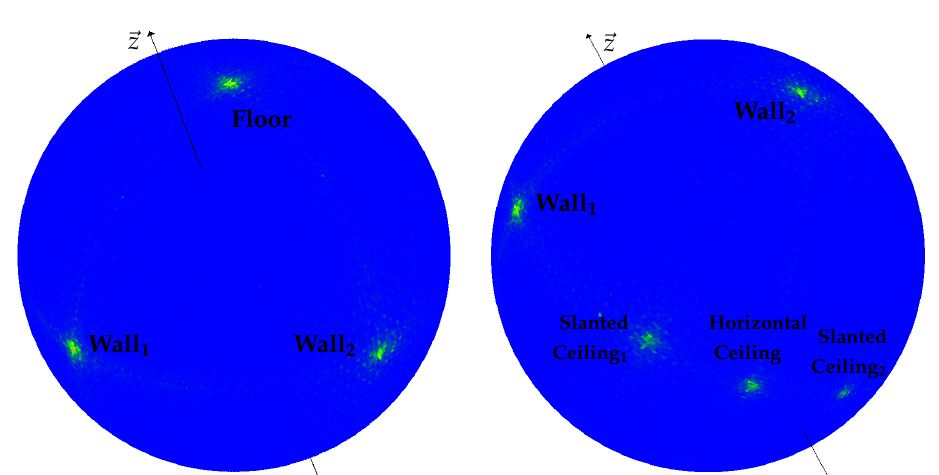
Figure 8. Azimuth ϕ and inclination θ .